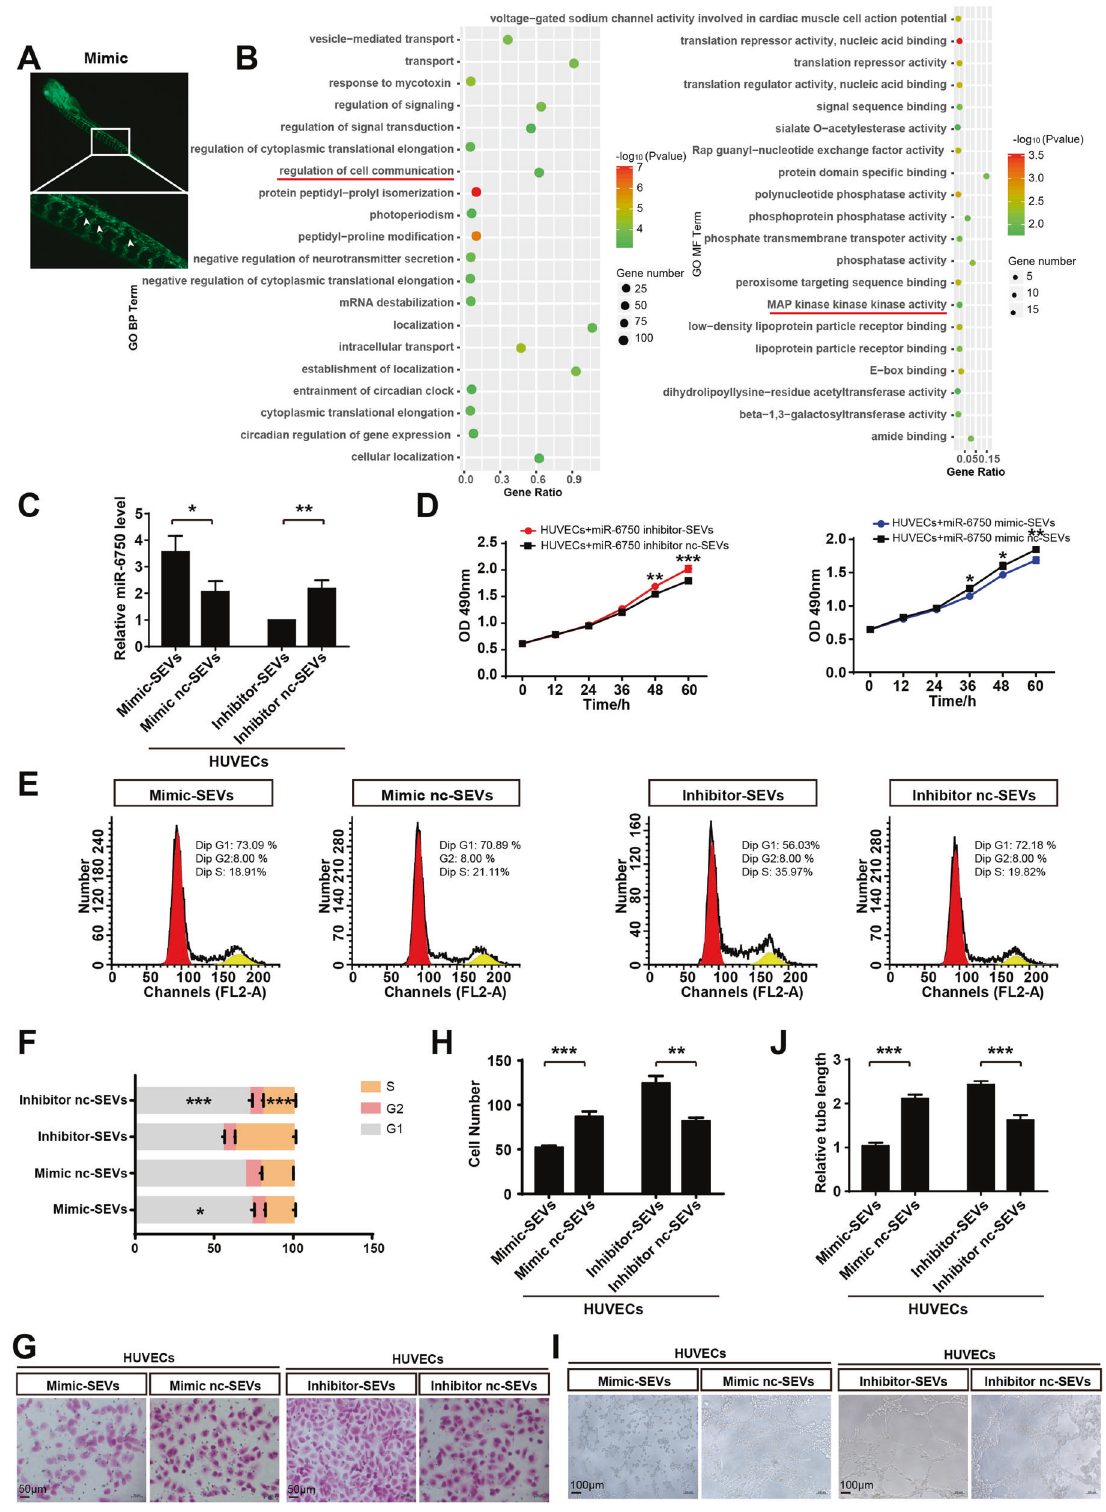
Fig. 2 MiR-6750-SEVs can be shuttled to HUVECs in TME to regulate angiogenesis. A CNE2 with higher miR-6750 level inhibit angiogenesis in zebra fi sh. B GO annotation analysis for miR-6750 target genes in the biological process and molecular function. C After co-cultured with CM-SEVs from CNE2 cells, miR-6750 levels in HUVECs were measured by qRT-PCR. Student ’ s t-test. D CCK8 assay was performed to measure viabilities of HUVECs treated as graph-depicted groups. Two-way ANOVA. E , F Cell-cycle analysis was used. One-way ANOVA. G , H Transwell migration assays were performed to measure cell migration. Student ’ s t-test. I , J Tube formation assays were performed using Matrigel. Student ’ s t-test.